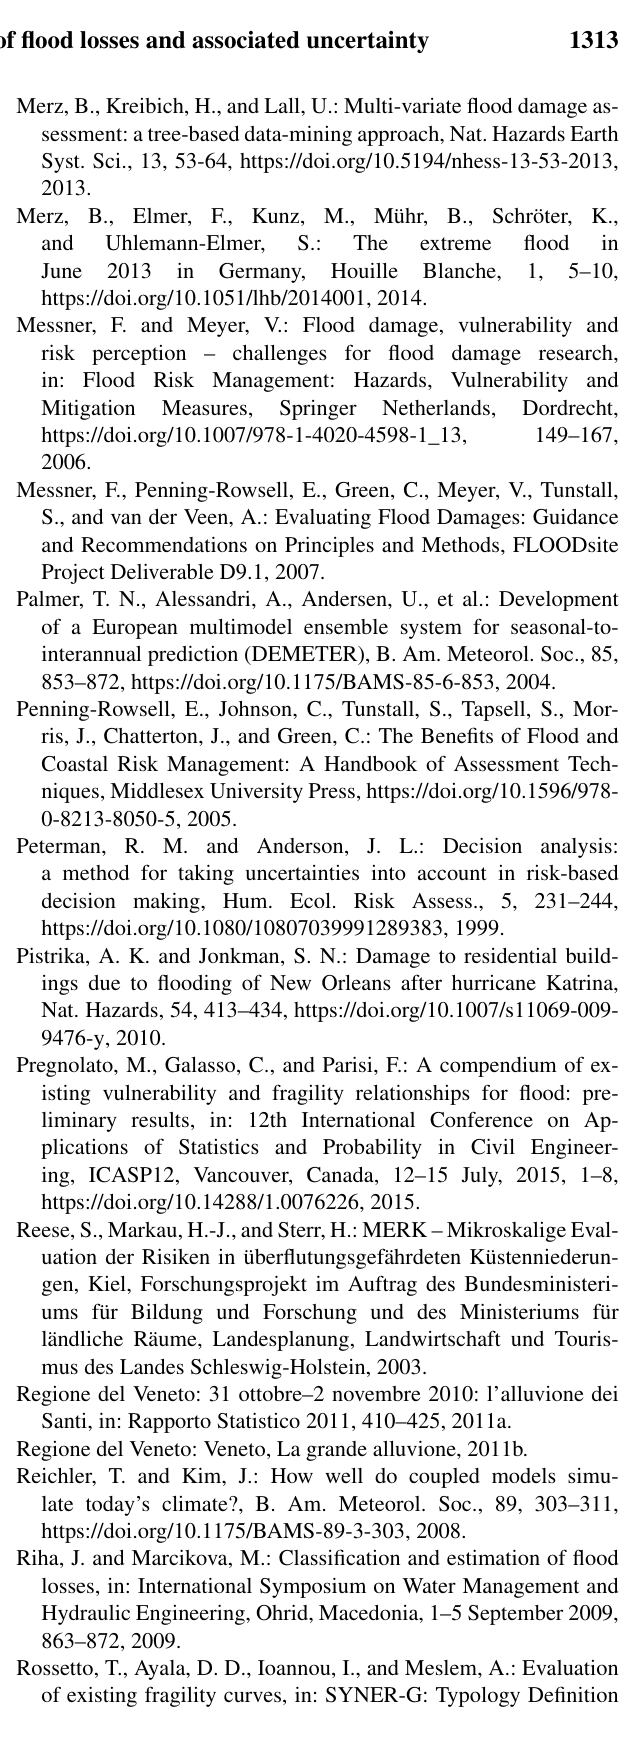
R. Figueiredo et al.: Multi-model ensembles for assessment of flood losses and associated